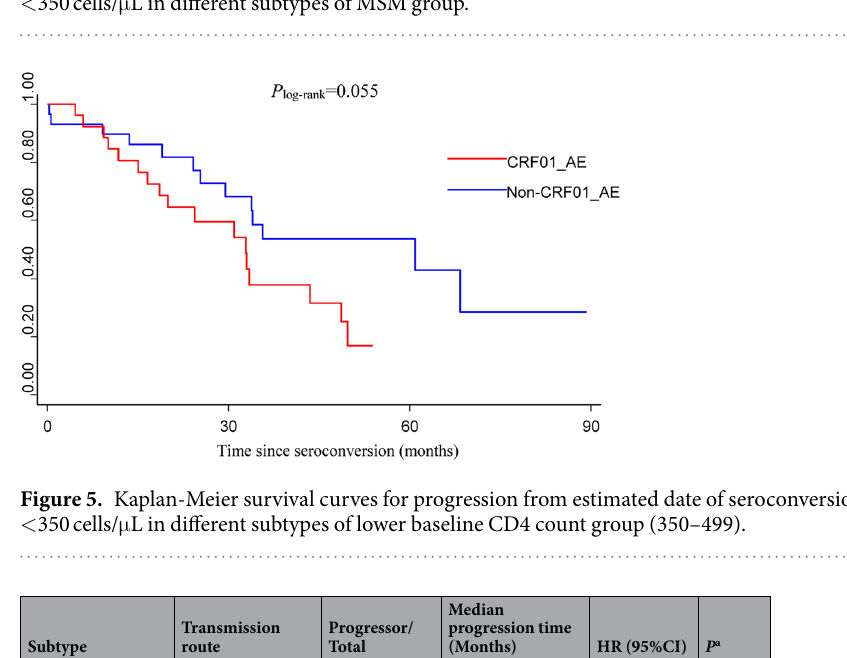
Figure 4. Kaplan-Meier survival curves for progression from estimated date of seroconversion to CD4 count < 350 cells/ μ L in different subtypes of MSM group.